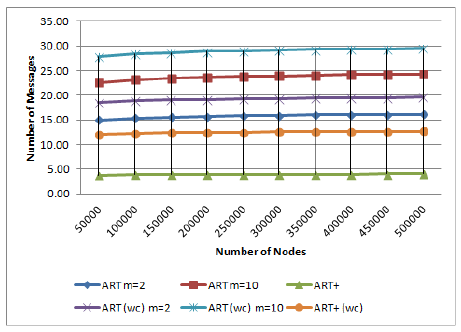
Figure 10. Cost of load-balancing